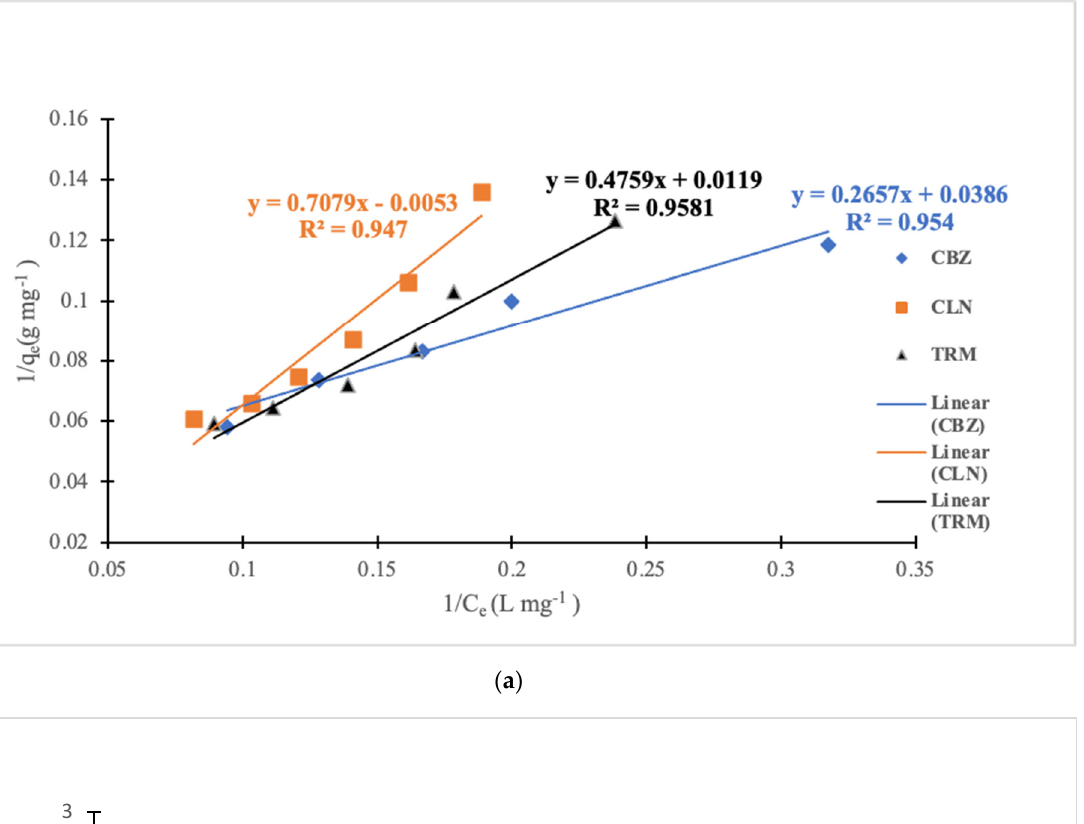
y = 0.8059x + 0.9515 R² = 0.9411